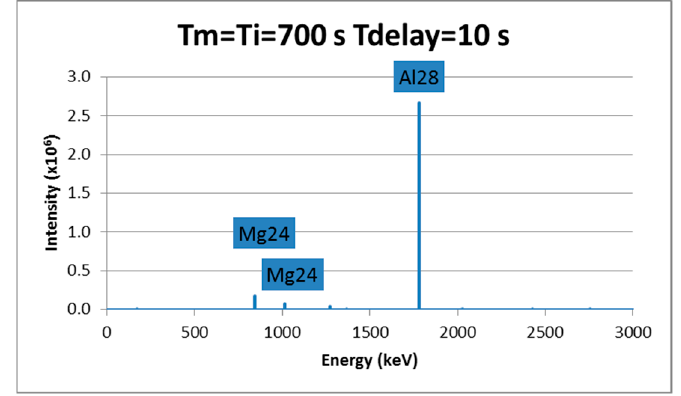
Figure 2. Theoretical spectrum for tm = ti = 700 s and td = 10 s standard